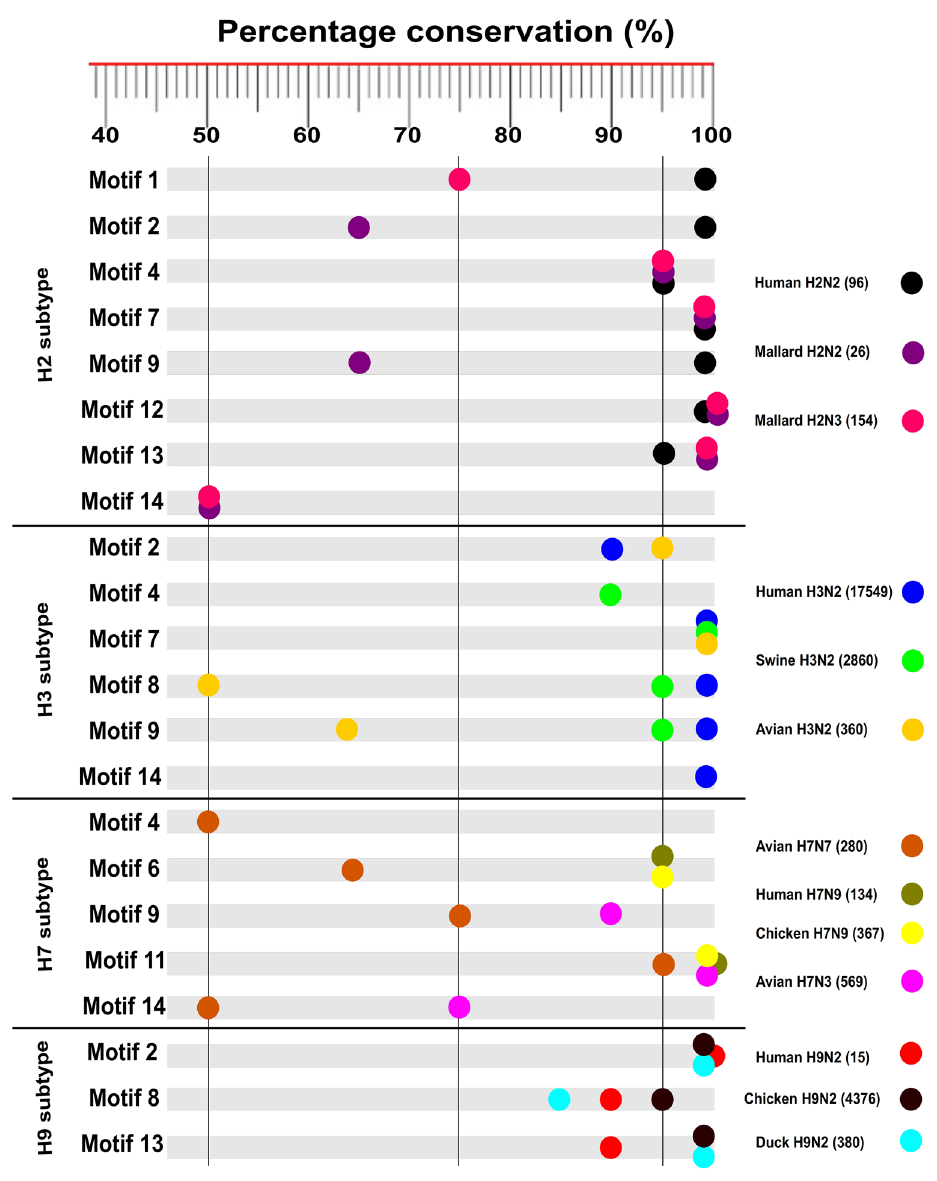
Figure 3. Summary of conserved DRACH motifs among some IAVs HA mRNAs. Conserved motifs, virus, host species, and the number of sequences listed on IRD are indicated. Conservation percent is indicated on the upper